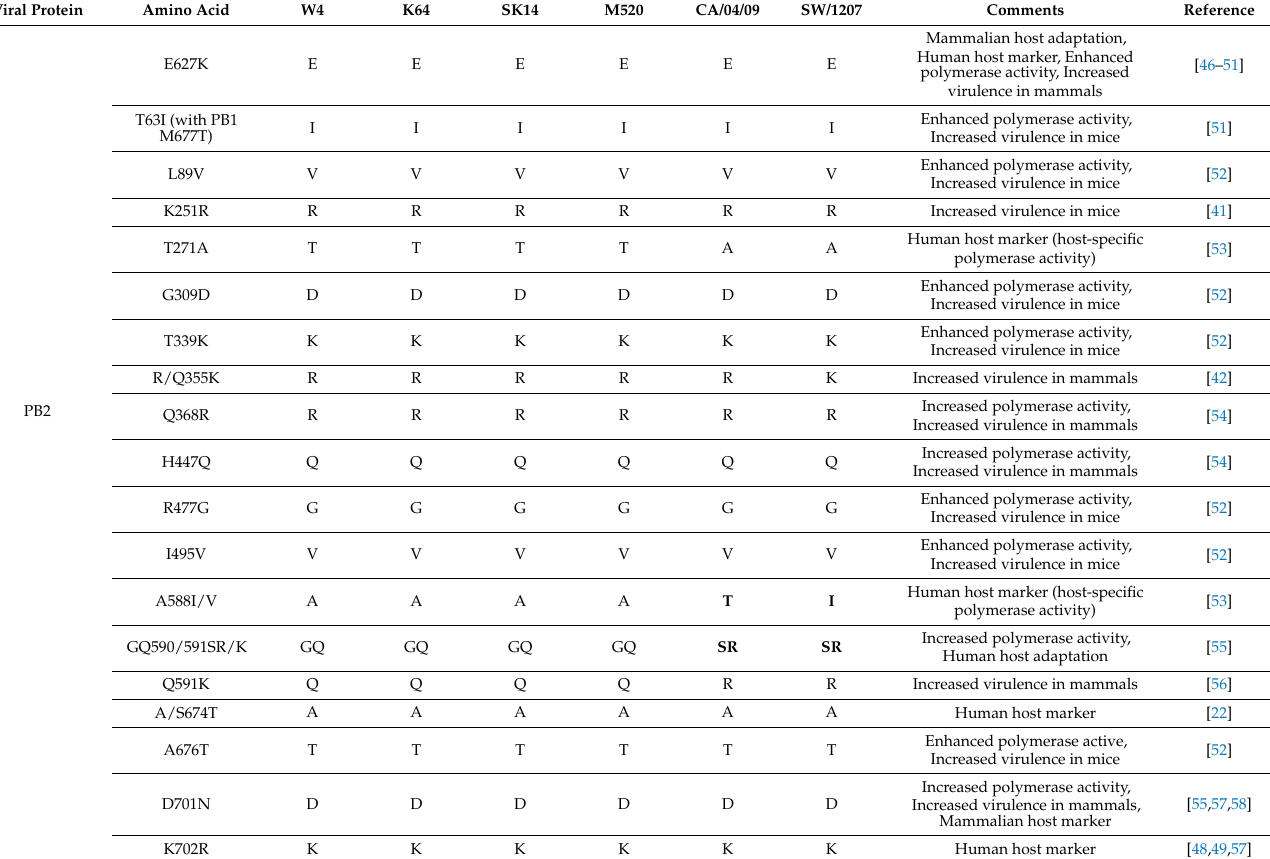
Table 3. Molecular characteristic of two novel isolate influenza A (H1H1) virus.